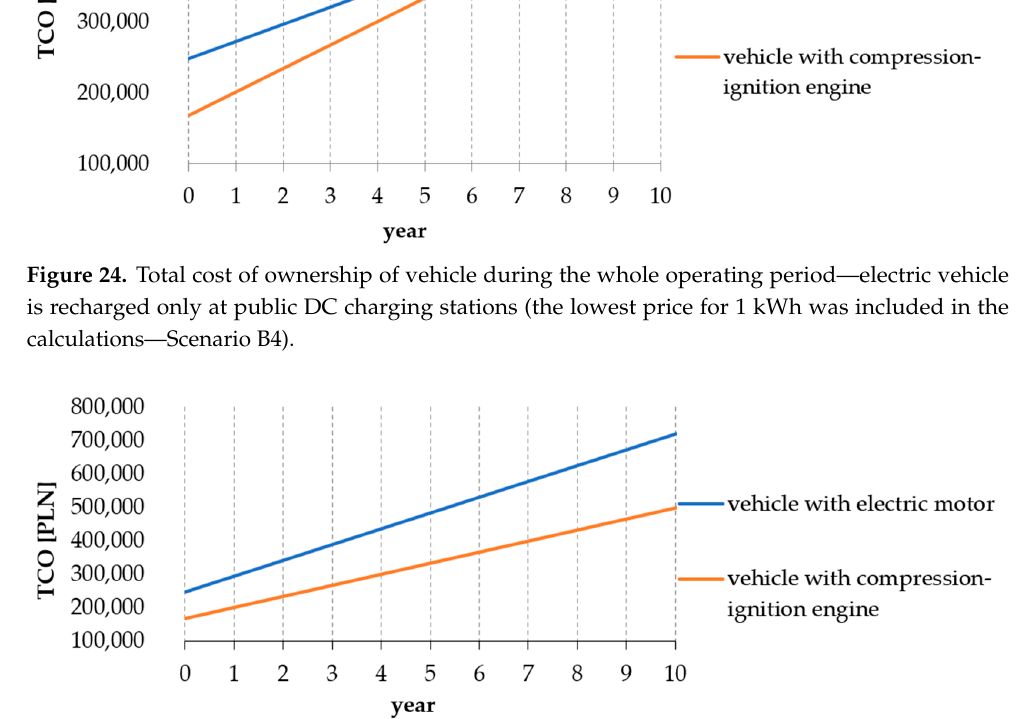
Figure 25. Total cost of ownership of vehicle during the whole operating period—electric vehicle is recharged only at public DC charging stations (the highest price for 1 kWh was included in the calculations—Scenario B5).